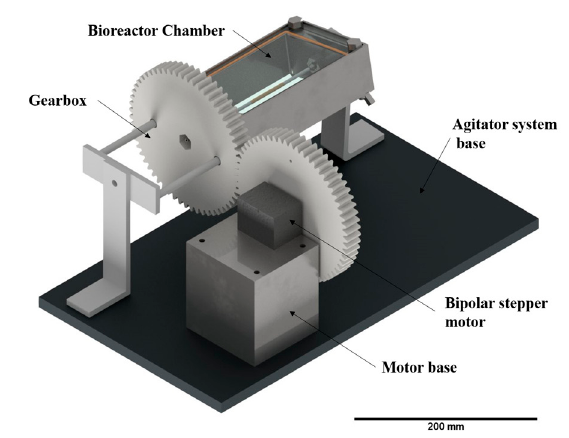
Figure 2. Assembly of the agitator system where the fluidic device was mounted to allow rotation in both the clockwise and counterclockwise directions.